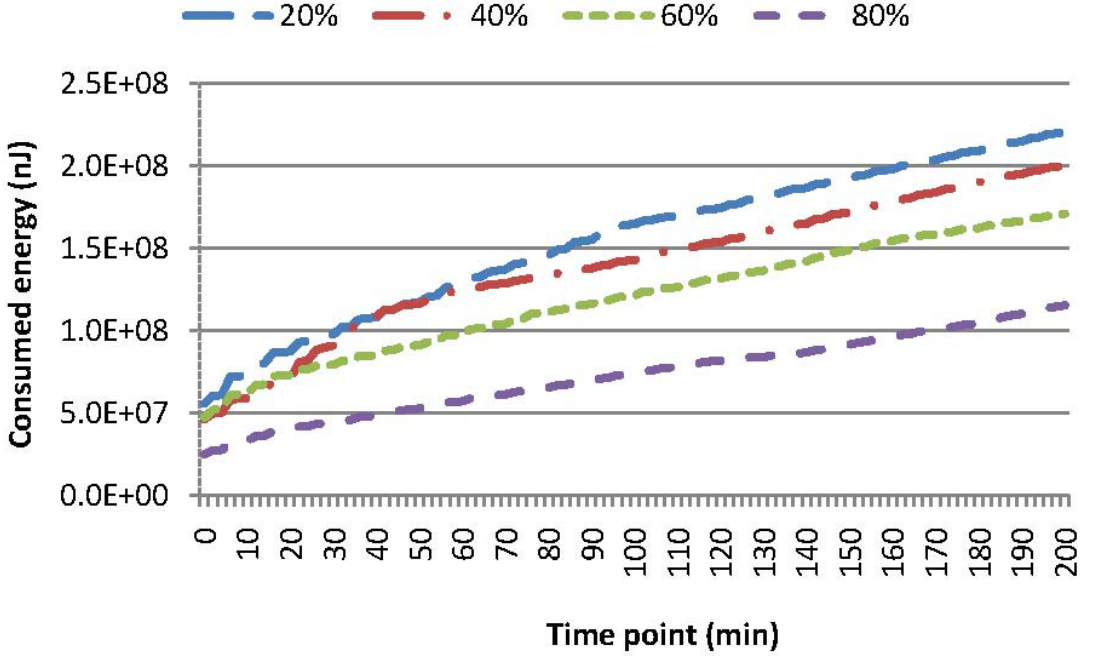
Figure 6. Comparison of the accumulated energy consumption for single-attribute query in the whole region (SAQWR), where the skewness degree for the sensor node distribution in the network is set to 20 % , 40 % , 60 % and 80 % , respectively. The gradient of the curves represents the ratio of energy consumption for answering the query. This figure shows that the bigger the skewness degree is, the less energy is consumed for answering the query. For instance, in comparison with the case when the skewness degree is set to 80 % , 73% (or 91%) more energy is consumed for the case when the skewness degree is set to 40 % (or 20 %